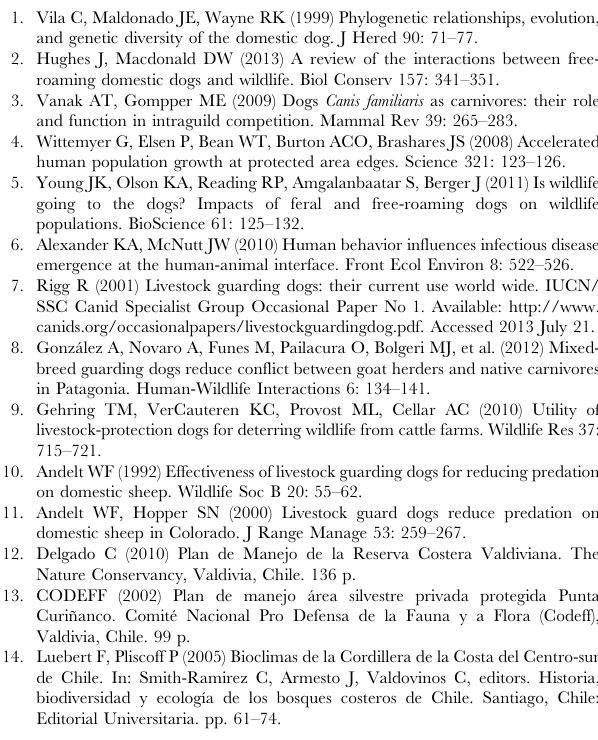
Table S1 Summary of model selection to estimate the probability of owned dog interactions with carnivores and prey species. Models are ranked by AICc values.